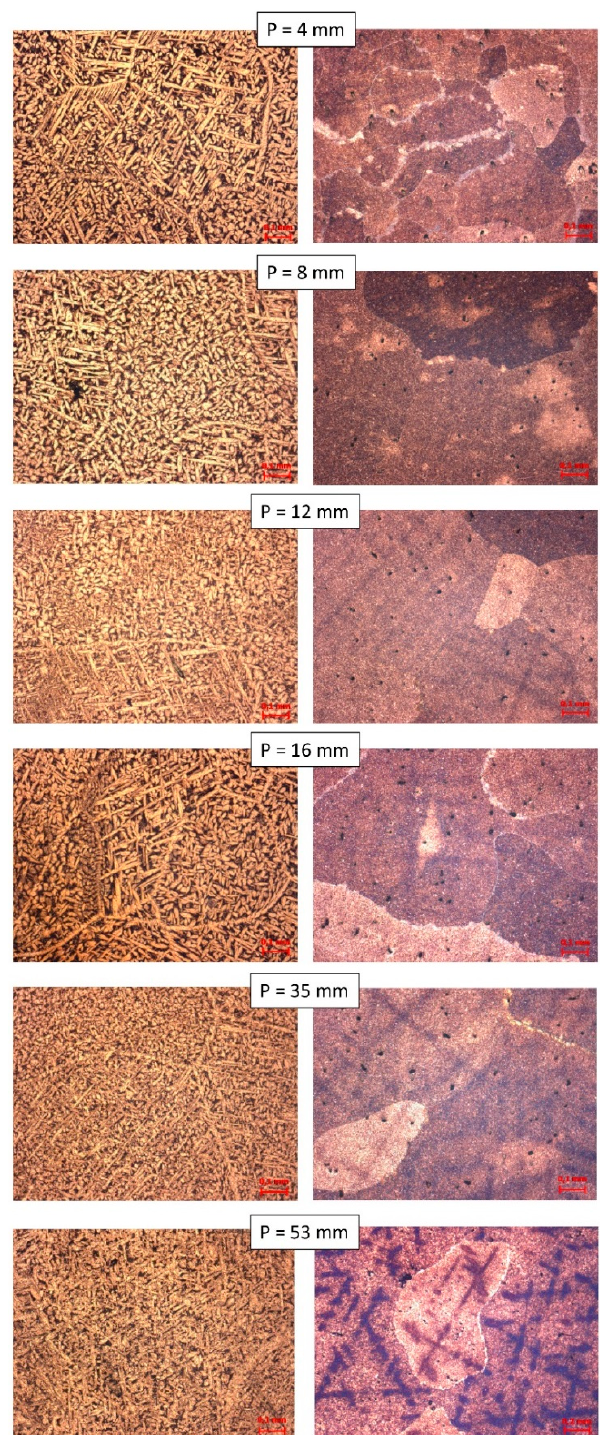
Figure 7. Micrograph of the various samples taken from different positions (P) as a function of the heat exchange surface: ( left ) Cu10Al alloy; and ( right ) Cu14Al alloy.